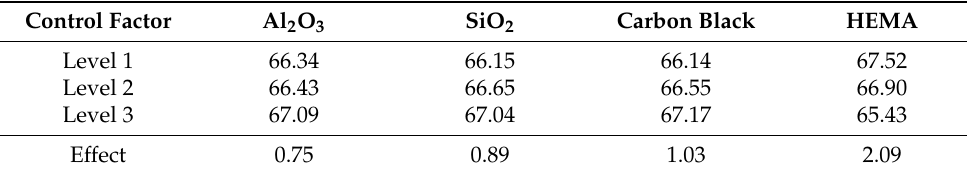
Table 7. Reaction table for the S/N ratio of storage modulus (unit: